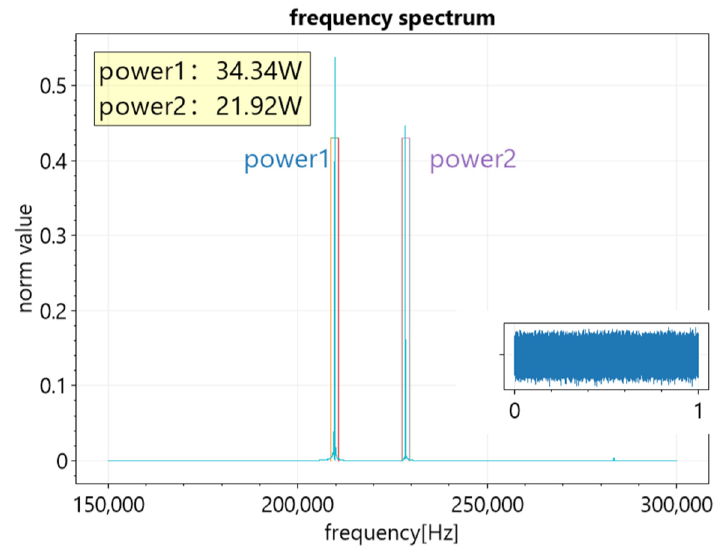
Figure 9. The current Sharing state estimation